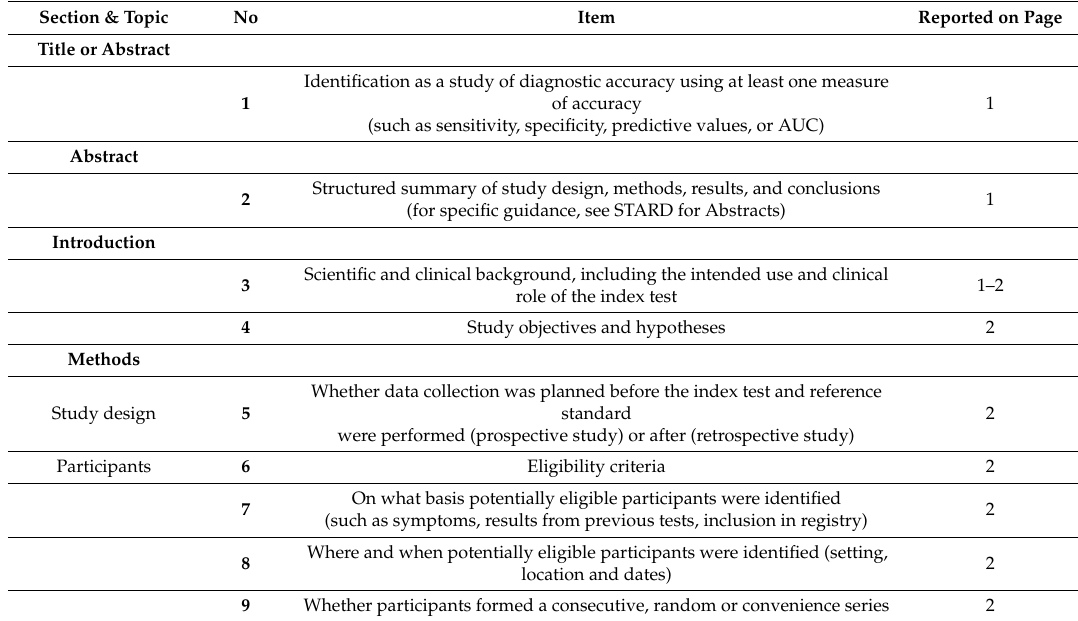
Table A1. The Standards for Reporting Diagnostic Accuracy (STARD)